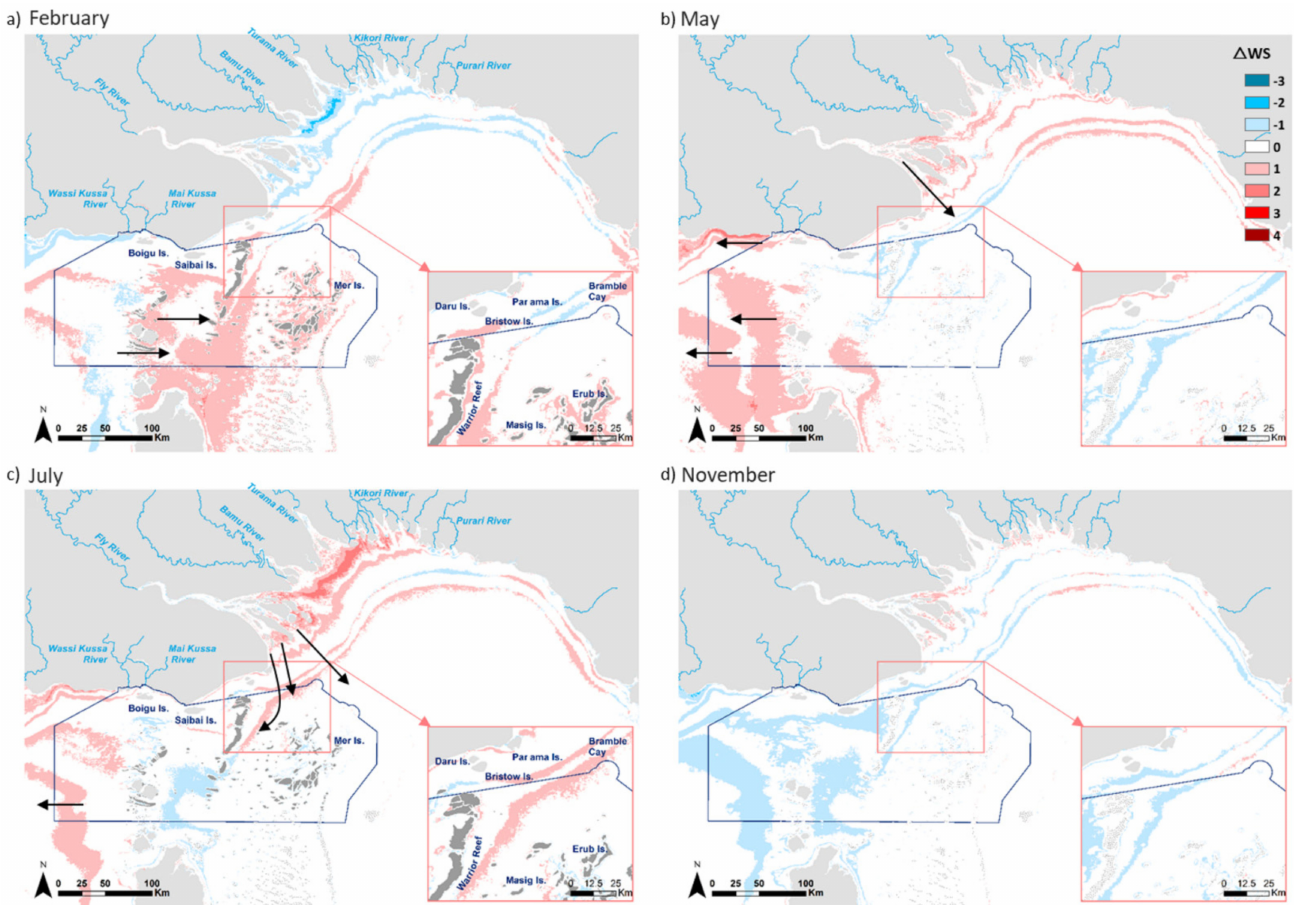
Figure 6. Decadal monthly difference maps illustrating areas with an increase (red, positive turbidity anomaly) or decrease (blue, negative turbidity anomaly) in turbidity in a selection of months relative to long-term patterns: ( a ) February, ( b ) May, ( c ) July and ( d ) November and zoom in map of Daru Island (bottom right corner). The monthly difference maps are calculated by subtracting the decadal median map (Figure 4) to the decadal median monthly maps (Table 3). ∆ WS is the difference in colour class category, with relative turbidity levels assumed to decrease from WS1 to WS7. Black arrows indicate tentative turbid water movement inferred from the difference maps ([22], modified). The whole series of monthly difference maps is available in Appendix